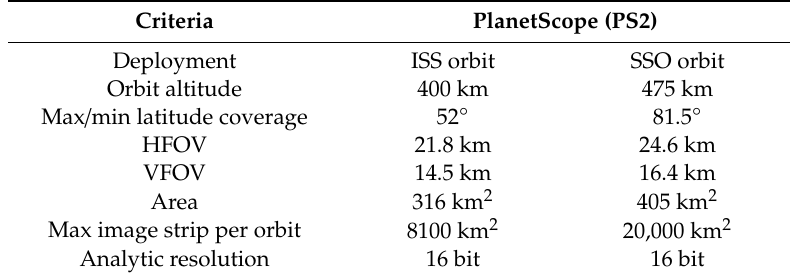
Table 2. Specifications of Planet Labs deployments in International Space Station (ISS) and Sun synchronous orbits